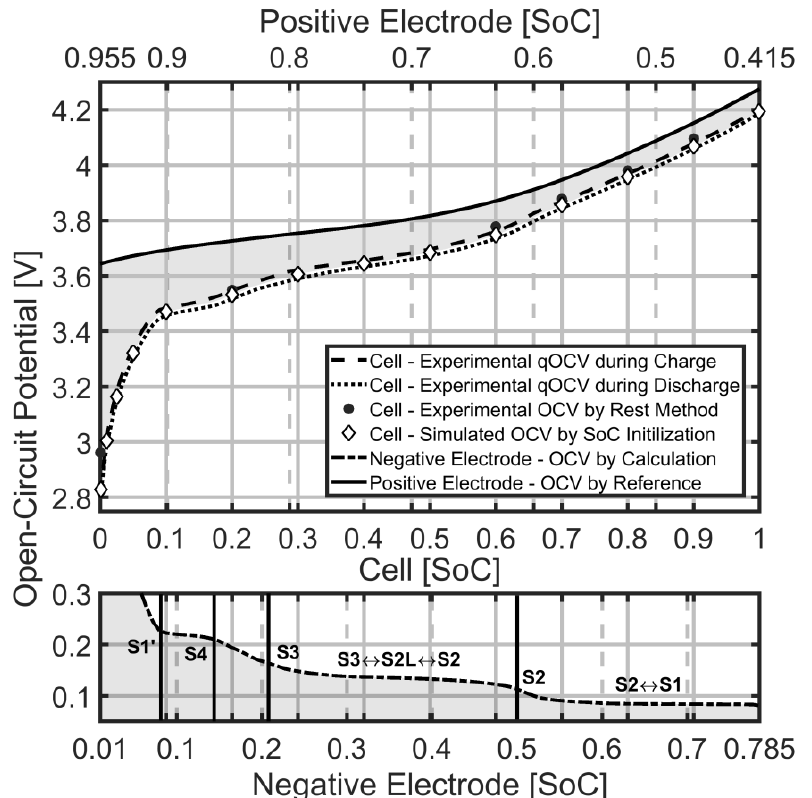
Figure 3. Experimental and simulated OCV and qOCV profiles (V) as a function of cell SoC and OCV profiles (V) as a function of electrode SoC and intercalation stages at the negative electrode